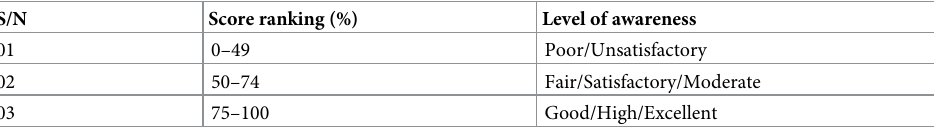
Table 1. How score-based awareness was